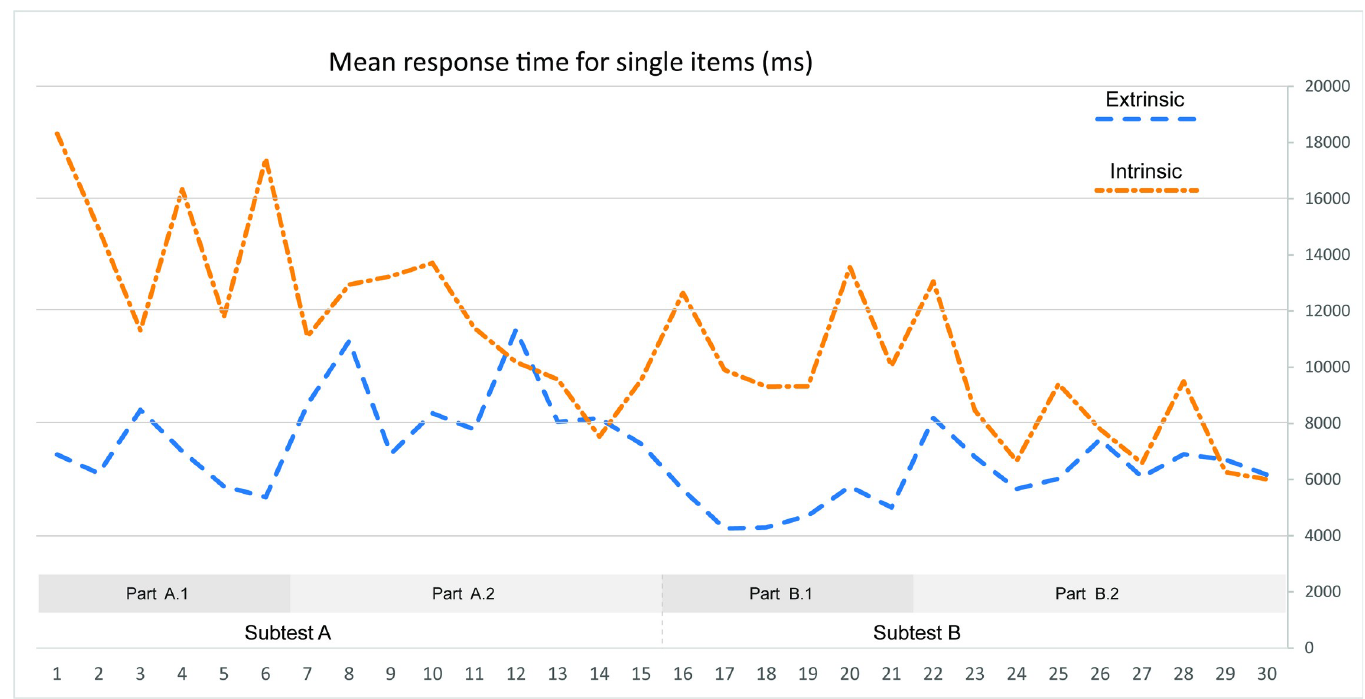
Fig 10. Mean response times (ms) per individual items for extrinsic and intrinsic visualization (all items).